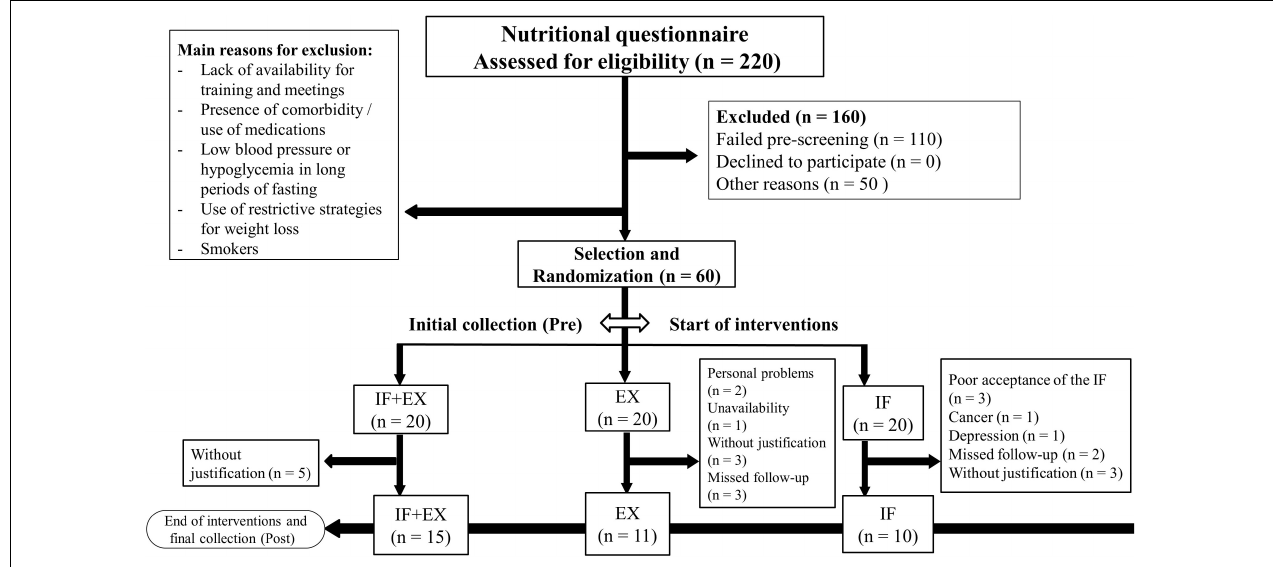
FIGURE 1 | Flow diagram. IF + EX, intermittent fasting group associated with exercise; EX, exercise group; IF, intermittent fasting